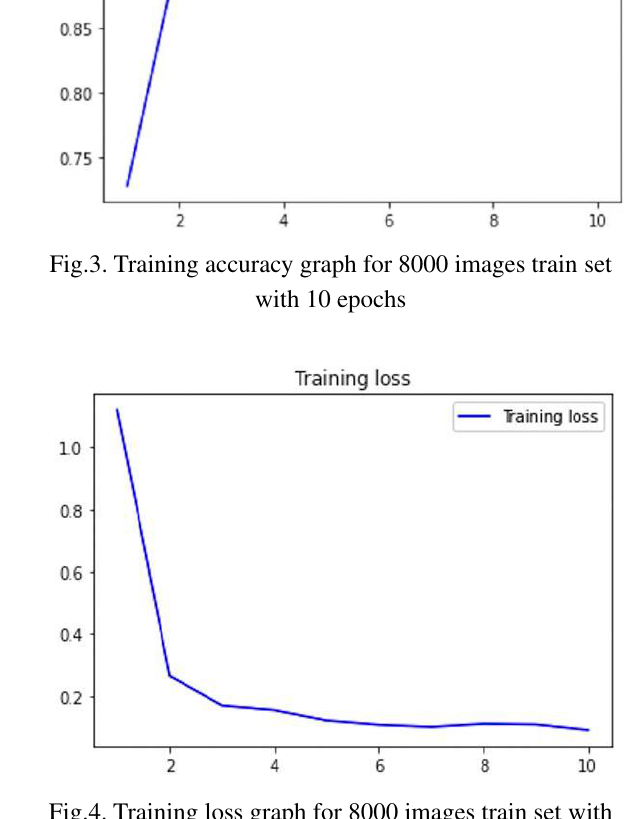
Fig.4. Training loss graph for 8000 images train set with 10